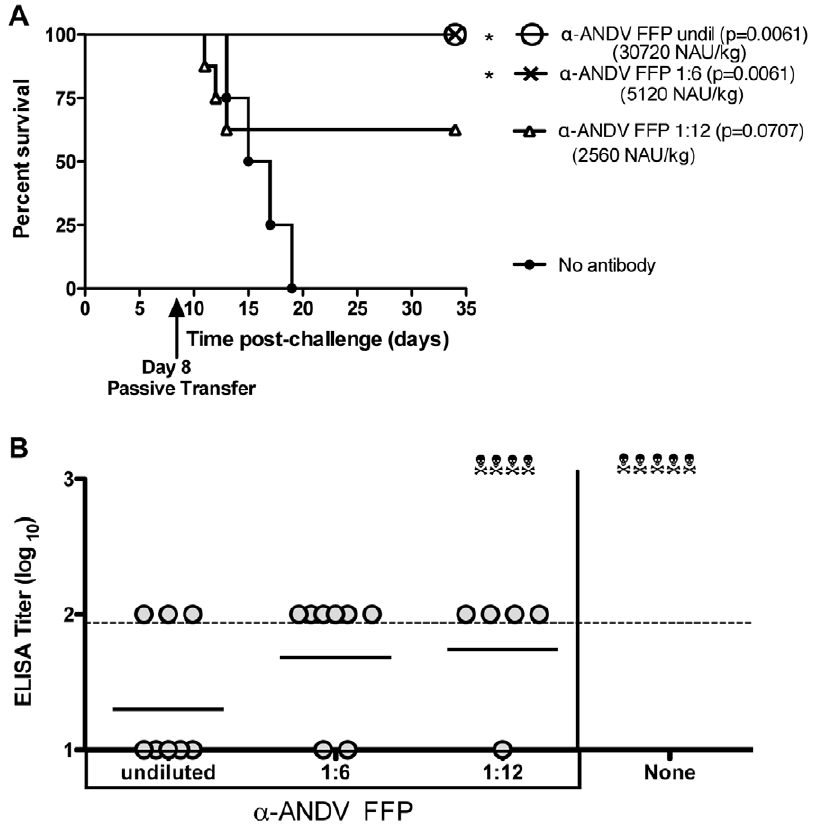
Figure 3. 5,000 NAU/kg of a -ANDV FFP is sufficient to protect hamsters from lethal HPS disease. A) Survival curve of hamsters challenged with 4,000 PFU of ANDV i.n. on day 0 and passively transferred with dilutions of a -ANDV FFP on day 8. P-values were determined by comparing FFP dilution to no antibody control. B) a -N ELISA endpoint titers (log 10 ) were conducted with sera from surviving hamsters challenged with ANDV in A). GMT for each group are shown.